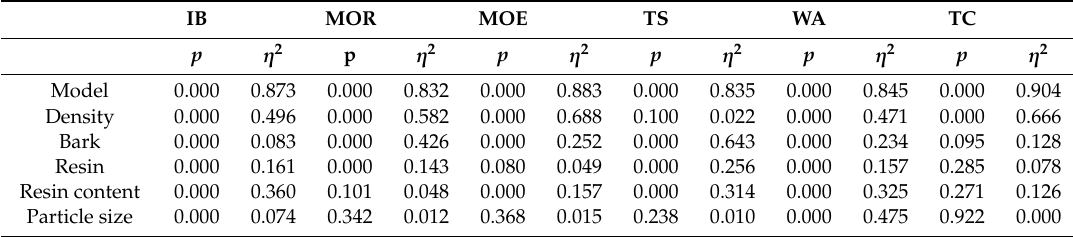
Table 3. Results of the ANOVA with p -values and η 2 -values for the explanatory